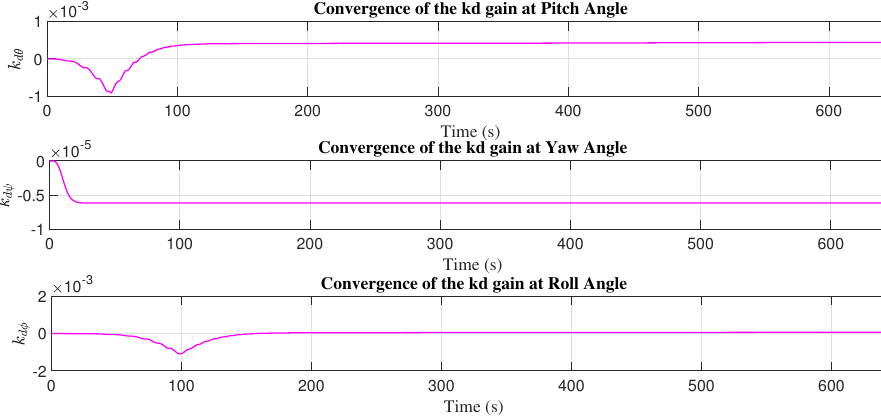
Figure 18. Convergence ˆ k d with MIT rule with sliding modes (MIT-SM). The control response to achieve the desired trajectory with the adaptive control law with MIT rule with twisting (MIT-Twisting) is presented in Figure 19. The minimization of the cost function with MIT-Twisting illustrates in Figure 20. Figures 21 and 22 present the convergence of the adaptive gains with the adjustment mechanism MIT-Twisting.